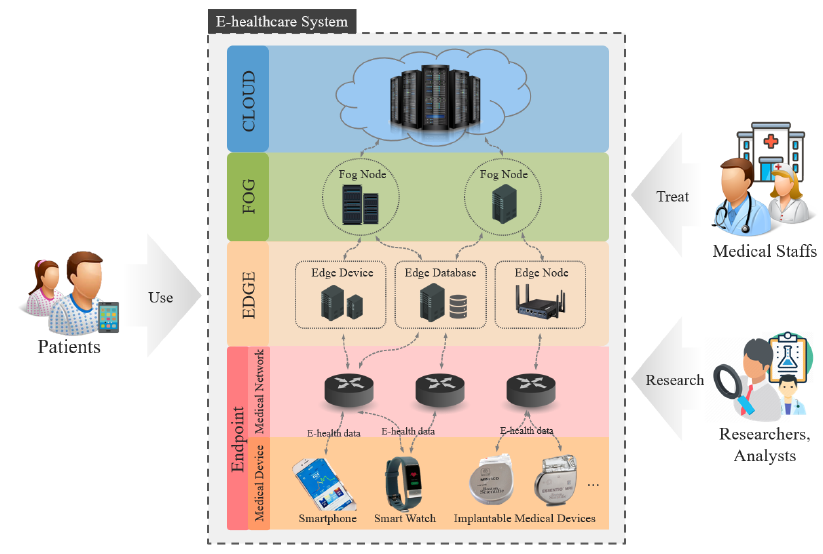
Figure 2. Overview of e-health system and the target domains.